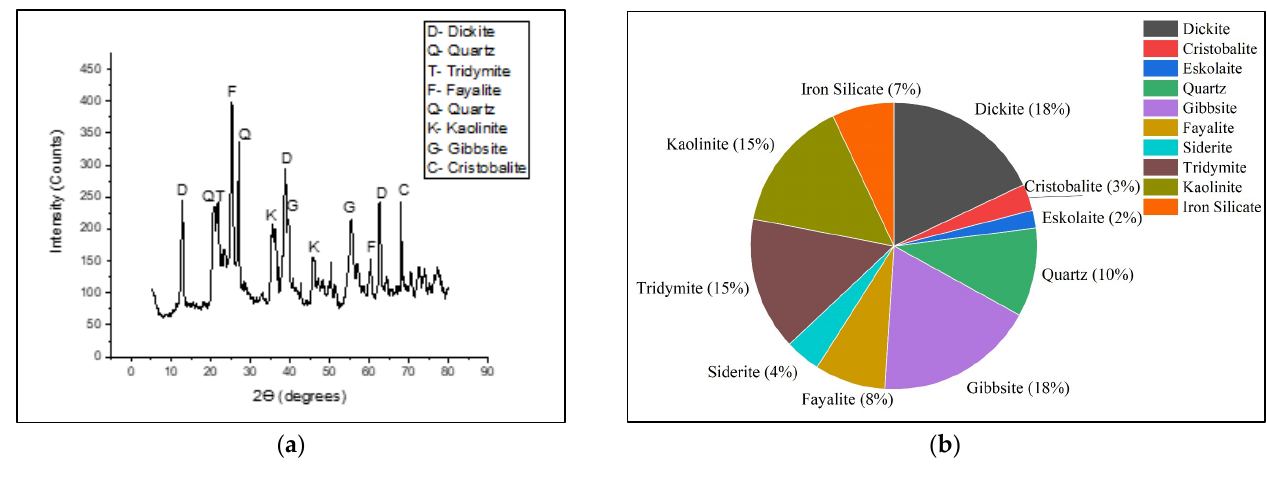
Figure 4. Characterization of minerals and compounds, ( a ) XRD analysis of Katapadi sample, ( b ) quanti fi cation of compounds.